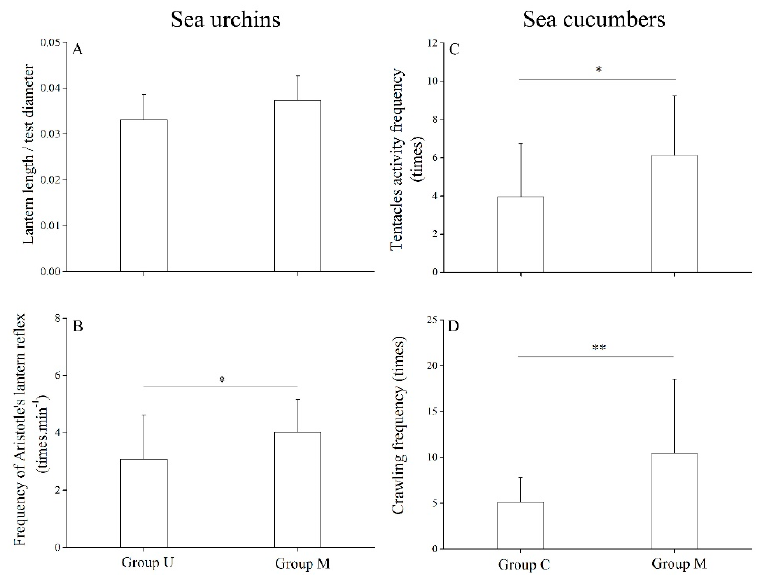
Figure 4. Lantern length/test diameter ( A ) and Aristotle’s lantern reflex ( B ) of Strongylocentrotus intermedius between groups U and M (mean ± SD, n = 6). Tentacles activity frequency ( C ) and crawling frequency ( D ) of Apostichopus japonicus between groups C and M (mean ± SD, n = 6). Group C: the control group for sea cucumbers. Group U: the control group for sea urchins. Group M: the integrated multi-trophic aquaculture of sea cucumbers and sea urchins. The asterisks * and ** mean p < 0.05 and p < 0.01, respectively.